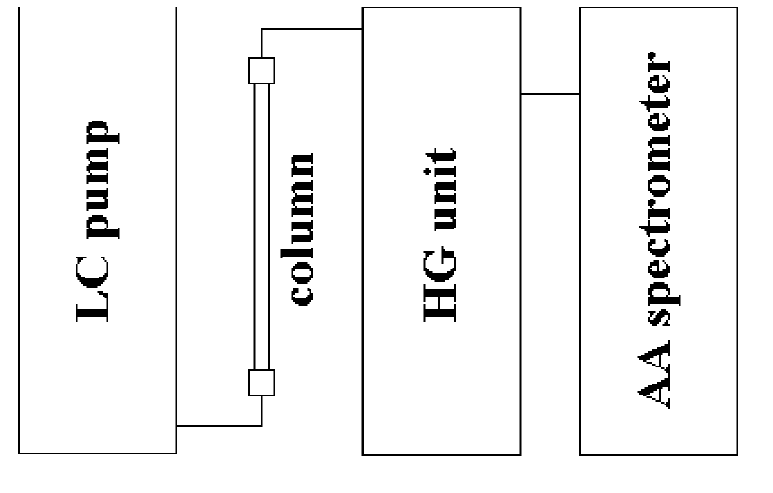
Fig. 1 Schematic diagram of the